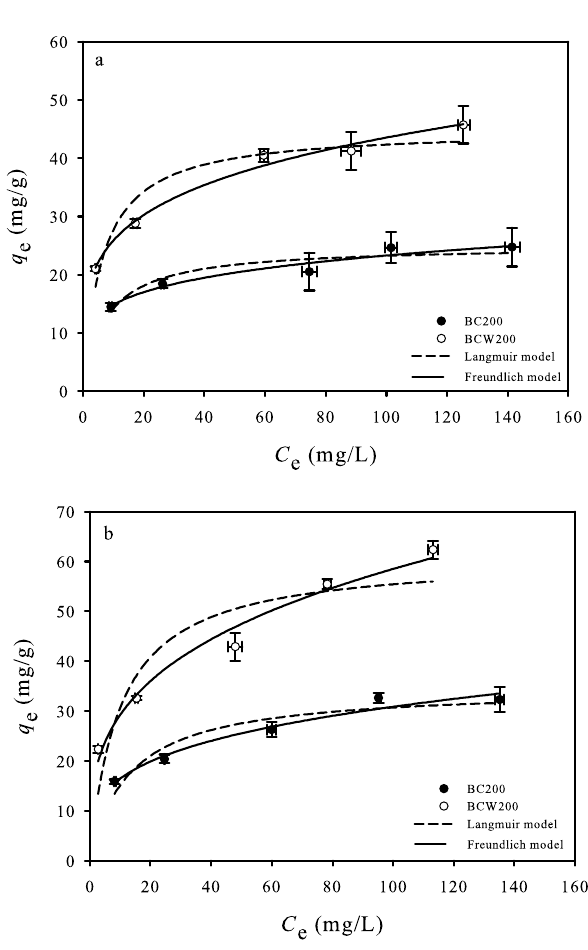
Figure 3. Sorption isotherms of OFL on BC200 and BCW200 at 15 °C ( a ) and 25 °C ( b ). [Conditions] 20 mL of 20–160 mg/L OFL; 0.0150 g of U.P -biochar; pH of 7.0 ± 0.2; 7 days. The experiment was conducted in triplicate.